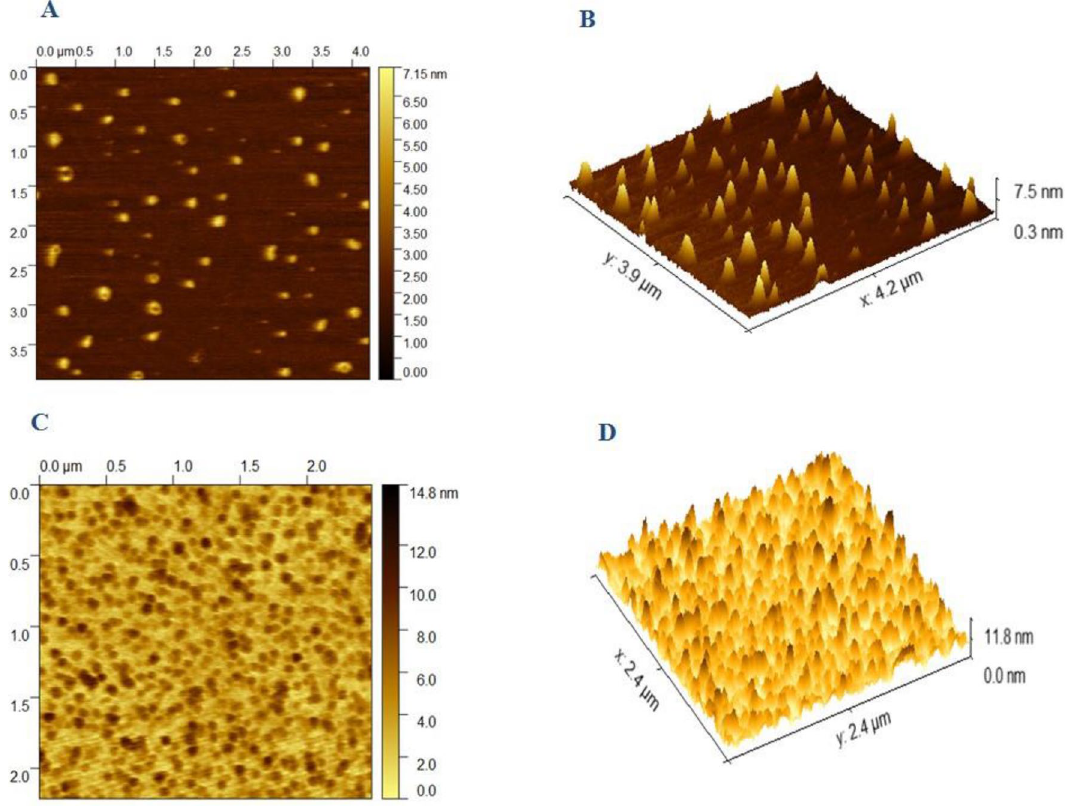
Figure 2. Morphology of empty liposomes ( A , B ) and liposomes Containing CD73 siRNA ( C , D ) by atomic force microscopy (AFM). Both empty liposomes and liposomes containing CD73 siRNA have spherical shape with high resolution and an average size of less than 100 nm. Figure ( A ) and ( C ) show the two-dimensional (2D) image of empty liposome and liposomes containing CD73 siRNA respectively. Figure ( B ) and ( D ) show the Three-dimensional (3D) images of empty liposome and liposomes containing CD73 siRNA